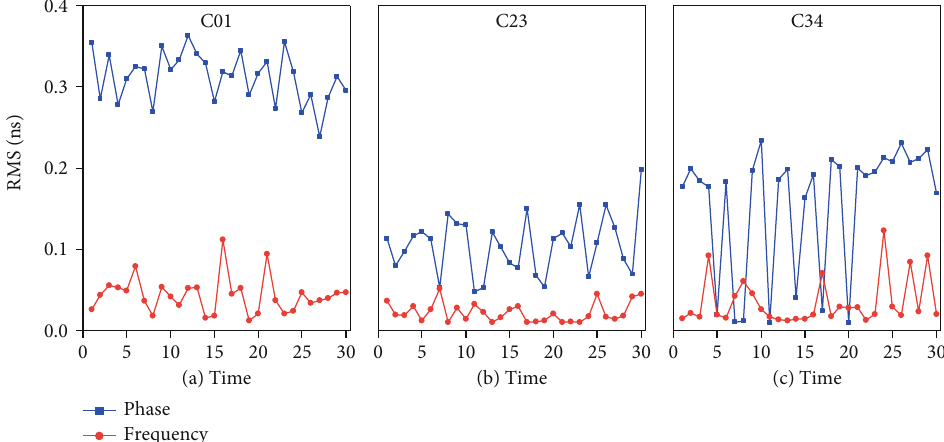
Figure 4: (a) The RMS value of 30 C01 continuous predictions. (b) The RMS value of 30 C23 continuous predictions. (c) The RMS value of 30 C34 continuous predictions. The red color denotes the results predicted using the phase data, and the blue represents the results predicted using the frequency data.